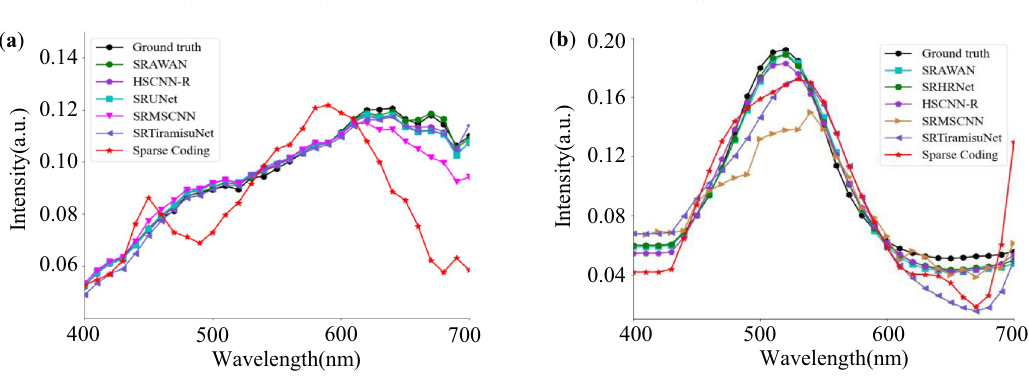
Figure 4. Performance comparison of selective SR methods using the residual heat map at 640 nm channel. The ground truth image is from the BGU-HS open-source dataset 27 . MRAE errors of Sparse Coding 29 ( a ), SRTiramisuNet 59 ( b ), SRMSCNN 35 ( c ), SRUNet 55 ( d ), HSCNN-R 60 ( e ), HSCNN-D 60 ( f ), and SRAWAN 63 ( g ) in the spatial domain.